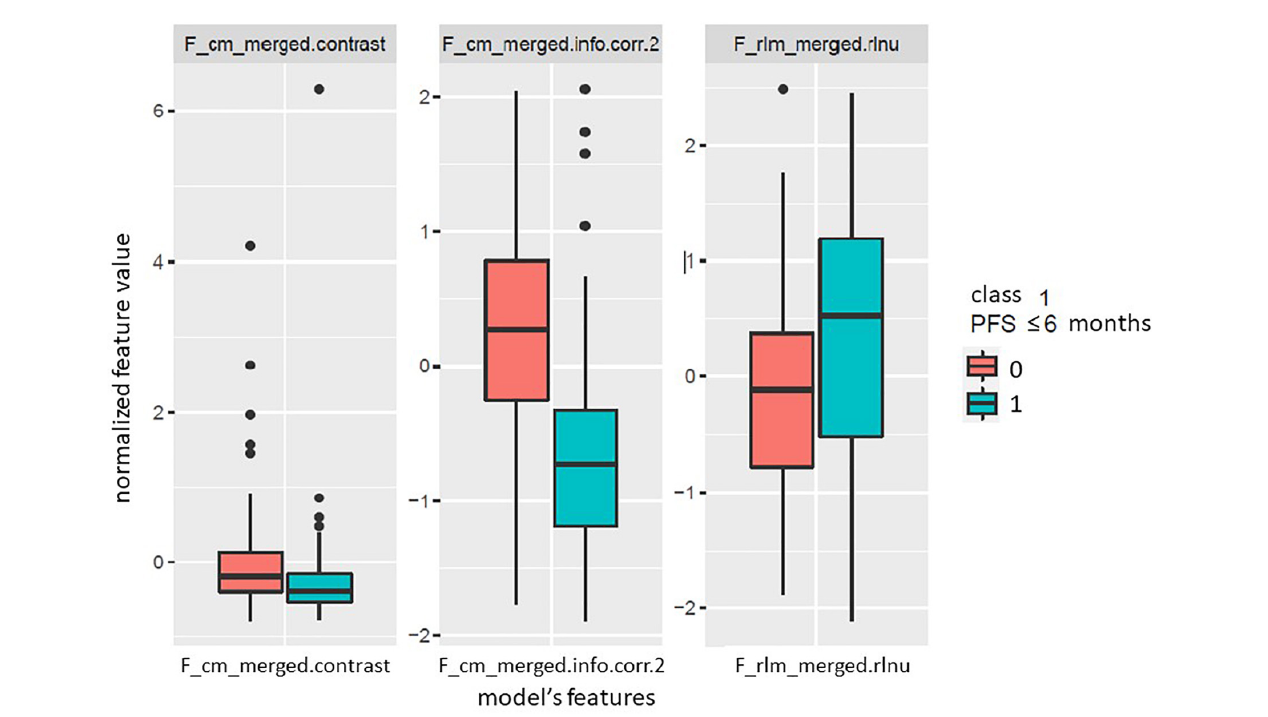
FIGURE3 Boxplots of the radiomic features included in the developed logistic regression model for the two classes of the outcome. Class 1 (cyan) indicates progression free survival (PFS) below or equal to 6 months, while class 0 (red) indicates PFS above 6